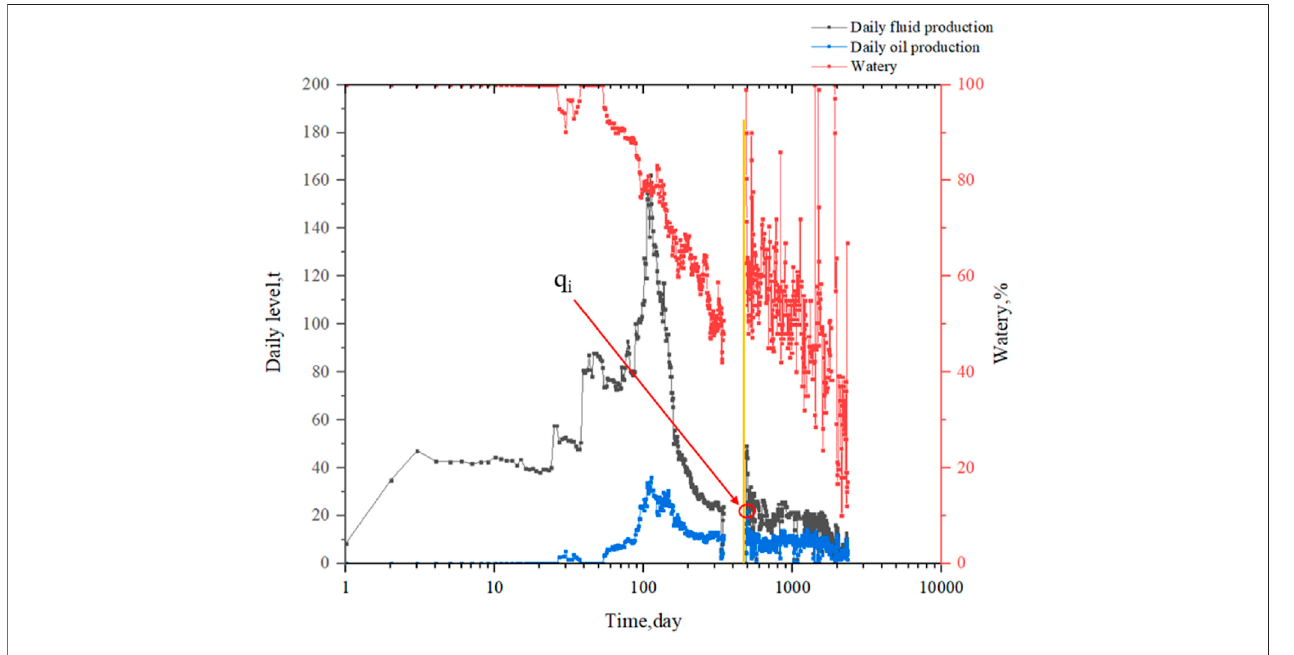
FIGURE 4 | Production performance curve of Well JHW018.